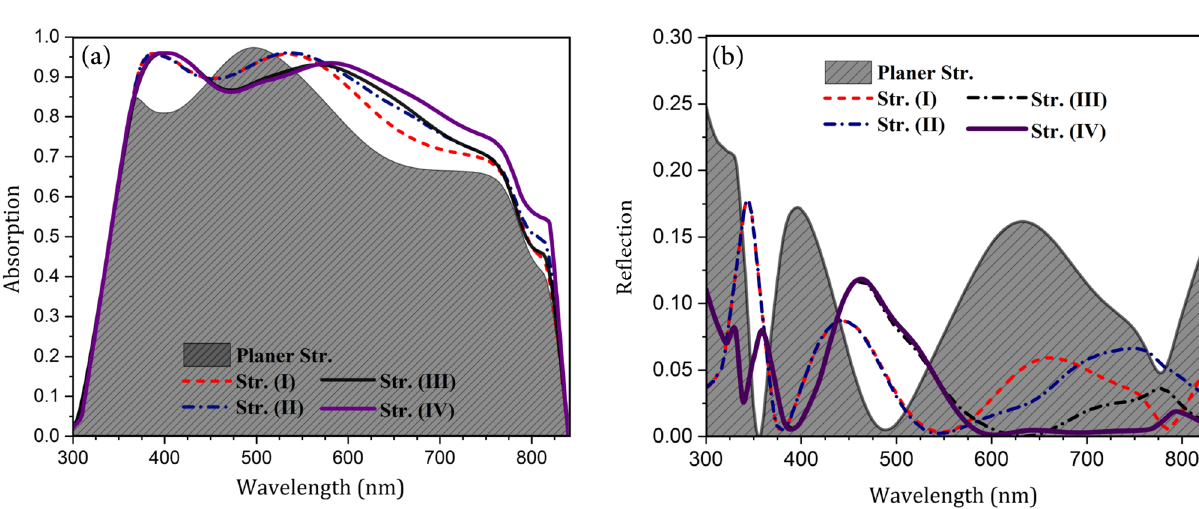
Fig. 4. Absorption of perovskite and total reflection of the cell for planar and presented structures. ( a ) Normalized absorption of the cell. ( b ) Normalized total reflection from the